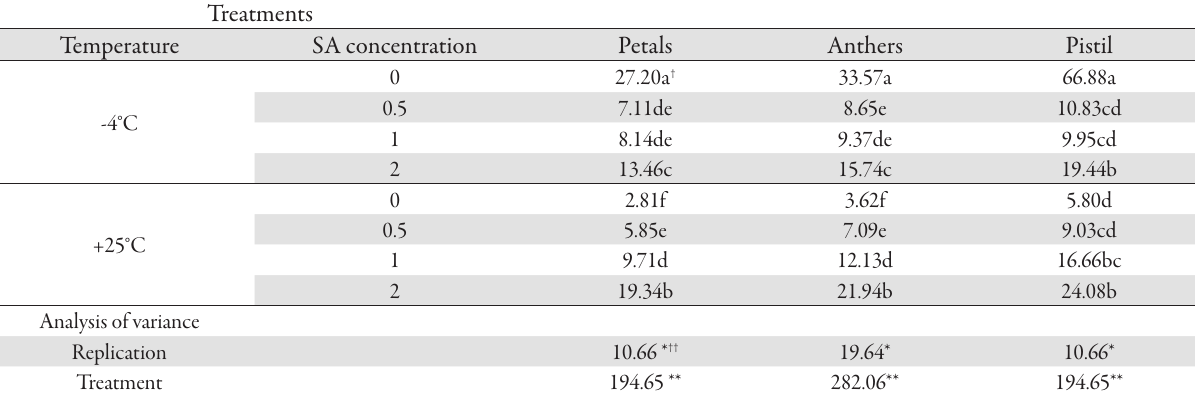
Tab. 1. Effect of exogenous SA pretreatment (0, 0.5, 1 and 2 mM) on damaged flower organs percentage in apricot flower buds under different temperature treatments (-4 and +25°C)